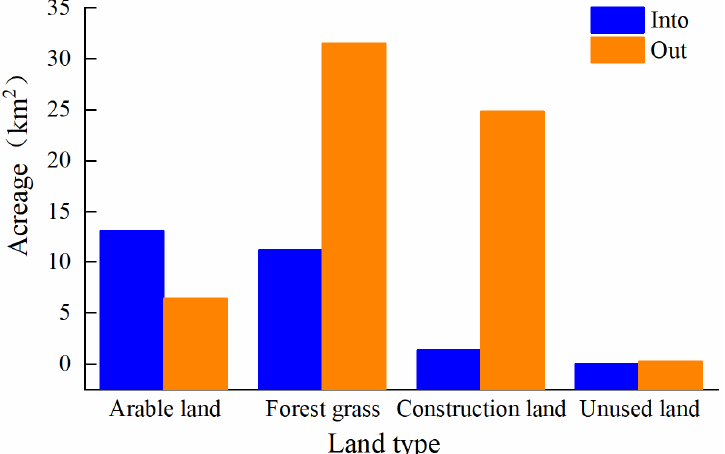
Figure 5. Analysis of water and other land types. Note: “Into” represents the transformation of other land-use types into water areas, and “Out” indicates the transformation of water areas into other land-use types.